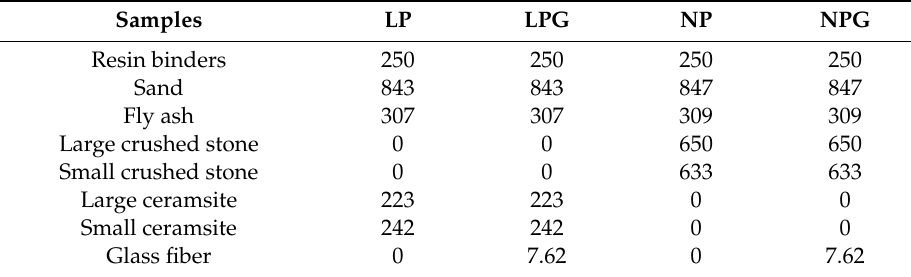
Table 4. Mix proportions of the concrete (kg / m 3